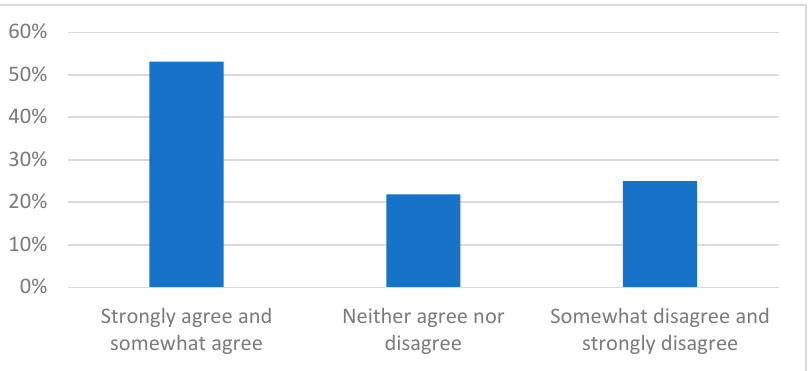
Figure 5. Is the IMO 2021 Cyber regulation the answer to cyber security for shipping? ( a ) Europe; ( b ) Asia.